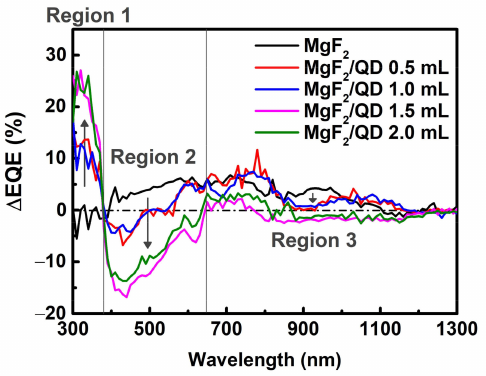
Figure 8. EQE differences between the reference CZTSSe solar cells and CZTSSe solar cells with varying quantities of CdSeS/ZnS